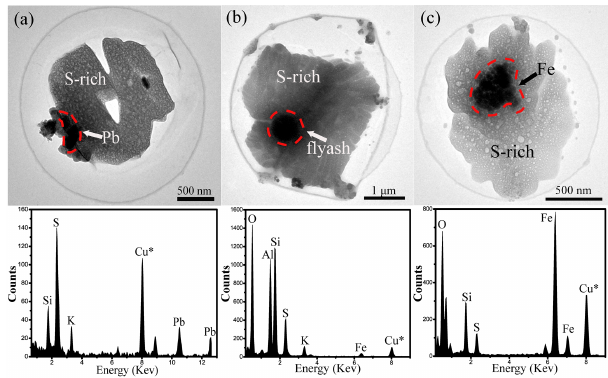
Figure 11. Typical TEM images and corresponding EDS spectra of metal particles embedded in individual S-rich cloud residues col- lected during cloud events. (a) Pb–S. (b) Fly ash–S. (c) Fe–S. The dotted red circles indicate the examined area of EDS. Cu* signals the result from the copper TEM